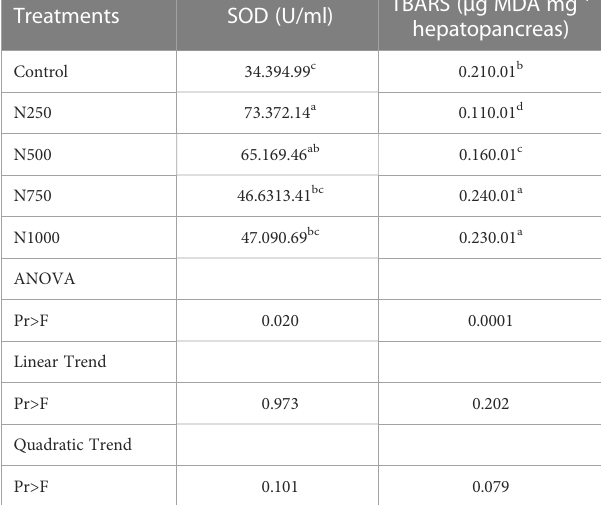
TABLE 5 SOD activity and TBARS levels in the hepatopancreas of white shrimp fed dietary treatments for 6 weeks.